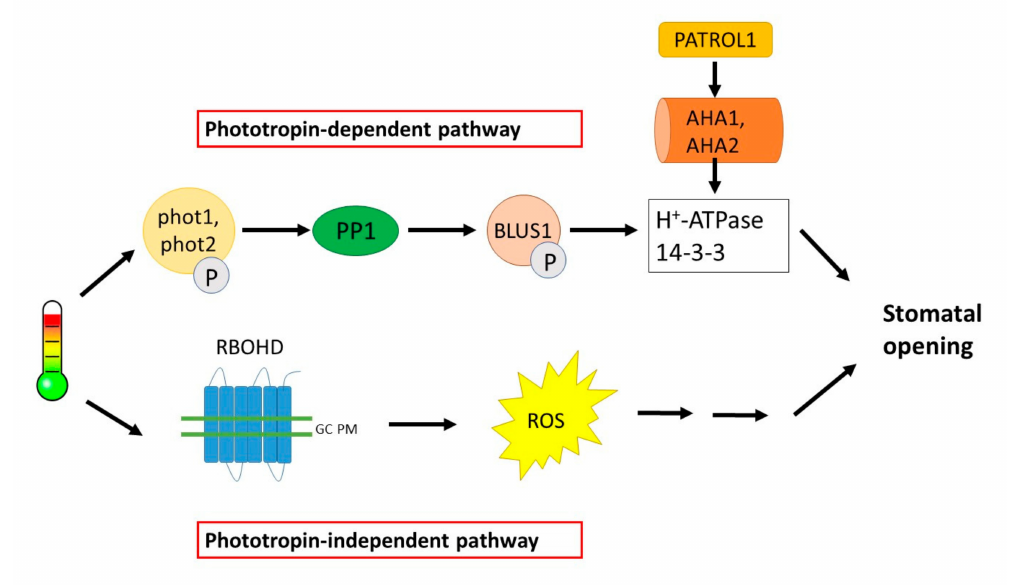
Figure 7. Temperature-induced stomatal opening. The phototropin-dependent pathway involves phototropin-mediated phosphorylation of BLUS1, activating PM H + -ATPases. AHA1 insertion into the PM is mediated by PATROL1. AHA1 regulates 14-3-3, promoting H + pumping. The phototropin-independent pathway involves RBOHD-mediated ROS production, resulting in stomatal opening. Phot, phototropin; PP1, protein phosphatase 1; BLUS1, blue light signaling 1; PATROL1, proton ATPase translocation control 1; AHA, Arabidopsis plasma membrane H + -ATPase; RBOHD, respiratory burst oxidase protein D; ROS, Reactive Oxygen Species; GC PM, guard cell plasma